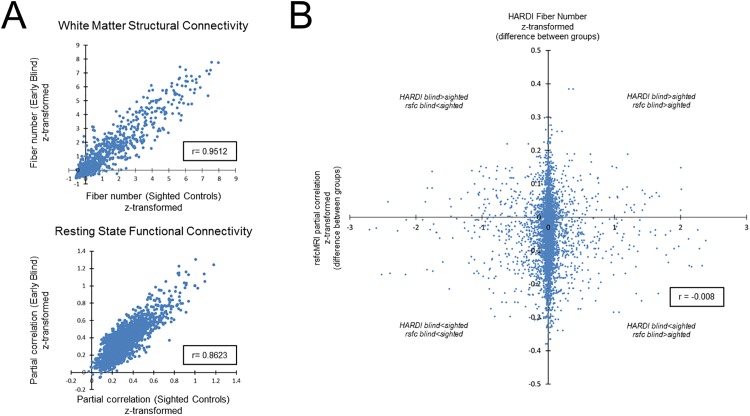
Correlation between white matter structural (obtained by HARDI) and resting state (obtained by rsfcMRI) functional connectivities.A) Scatter plot depicting the degree of association characterizing white matter structural (upper panel) and resting state functional (lower panel) connectivity between early blind and sighted controls. The measure of association (Pearson’s coefficient) was found to be highly significant (p<0.0001) for both white matter structural connectivity and resting state functional connectivity (r = 0.9512 and r = 0.8623, respectively). B) Scatter plot depicting correlations on all t-statistics of early blind compared to sighted controls for both white matter structural connectivity (HARDI fiber number) and functional connectivity (resting state partial correlations). Associating relative changes in white matter and functional connectivity between early blind and sighted controls were not statistically significant (r = -0.008, p>0.05).